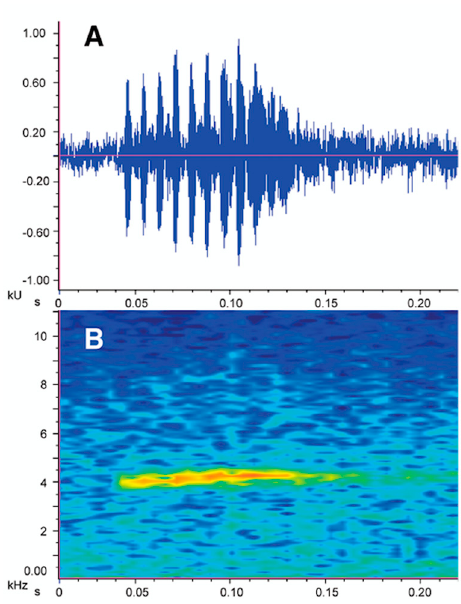
Figure 172. Call of Nymphargus manduriacu , LBE-C-042, from Reserva Río Manduriacu. ( A ) Oscillogram . ( B ) Audio-spectrogram. Obtained from Guayasamin et al. [21]. Tadpole: Not described.